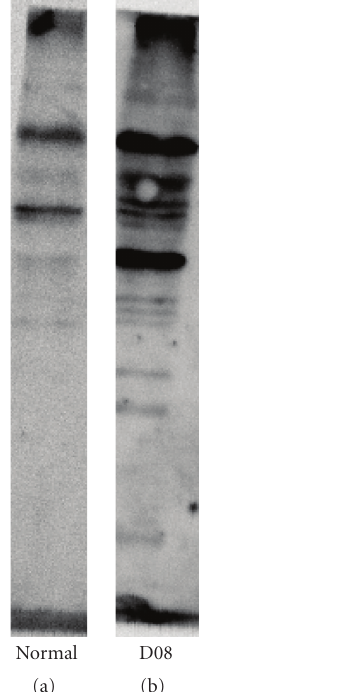
Figure 5: Mouse hyperimmune sera against D08 peptide recognize proteins in the A549 cell lysate. Proteins in the cell lysate of A549 cells were separated by SDS-PAGE and transferred to membrane as described in Section 2. Western blots against this membrane using normal mouse sera (a) or hyperimmune sera against D08 (b) are shown.